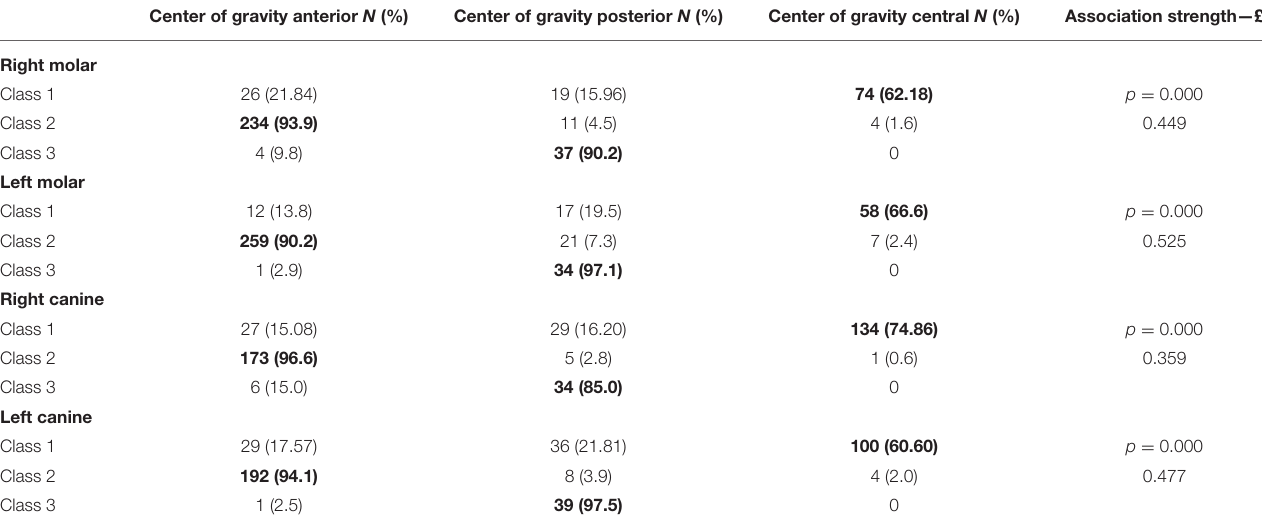
TABLE 4 | Relation between center of gravity and Angle’s class. Center of gravity anterior N (%) Center of gravity posterior N (%) Center of gravity central N (%) Association